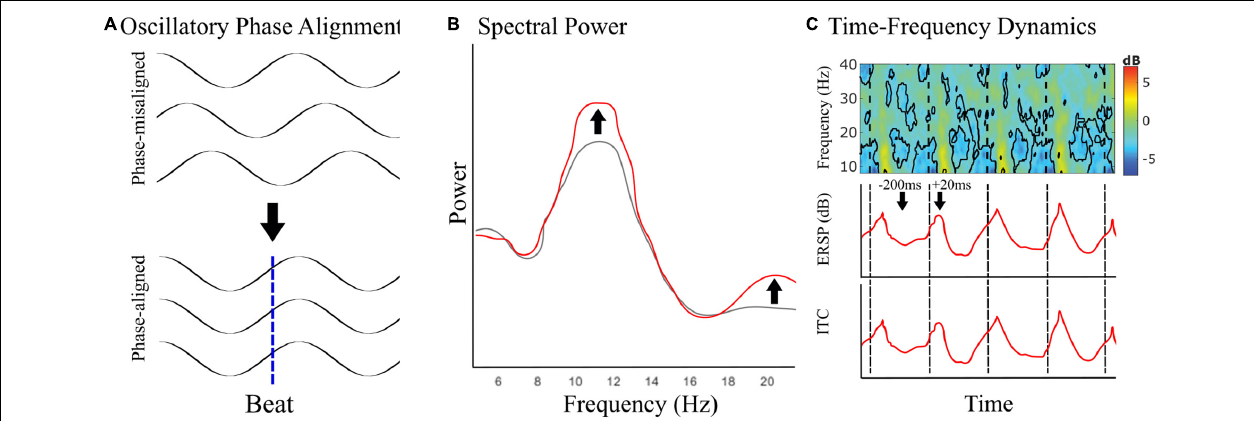
FIGURE 2 | Covert motor engagement in EEG. (A) Schematic showing phase-alignment in motor-related oscillatory brain activity to the predicted musical beat times during passive music listening. (B,C) Signatures of covert motor engagement in electrophysiological recordings–spectral power changes ( B , schematic) and time-frequency dynamics [ C , in this example to rhythmic auditory events during passive listening as described by Comstock et al. (2021)]. Event-related spectral perturbation (ERSP) is used to observe averaged dynamic changes in amplitude of the broad band frequency spectrum as a function of time and captures phase shifts in ongoing oscillatory activity. Inter-trial coherence (ITC) describes how consistent oscillatory phase is across trials and can be used to quantify phase locking to an event. If the time course of averaged ERSP and ITC is the same, then the event is phase locking oscillations consistently across trials.